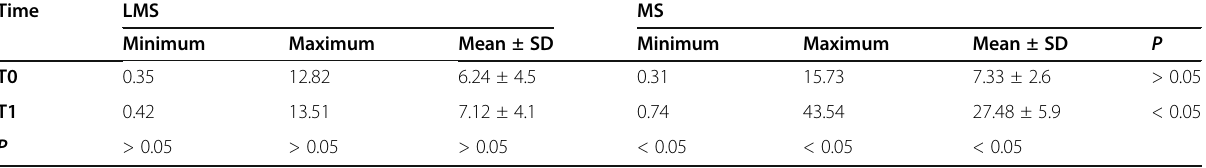
Table 4 Comparison of the level of interleukin IL-6 (pg/mL) detected in the LMS and MS groups